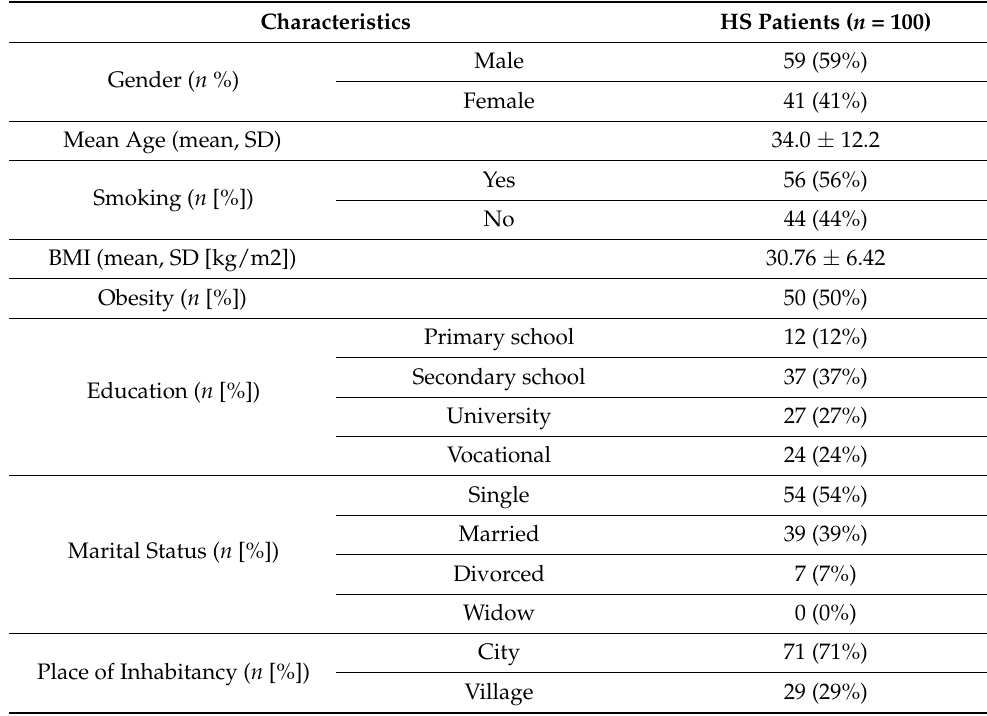
Table 1. Demographic and clinical characteristics of HS